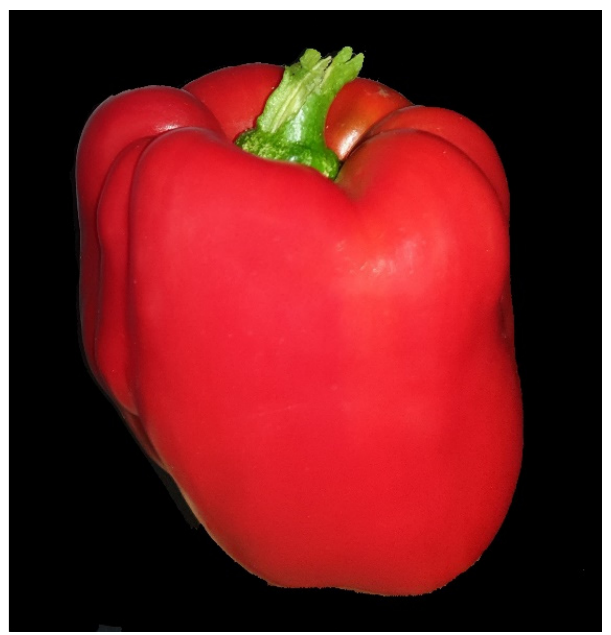
Figure 1. The sample of red bell pepper fruit used in the experiments.